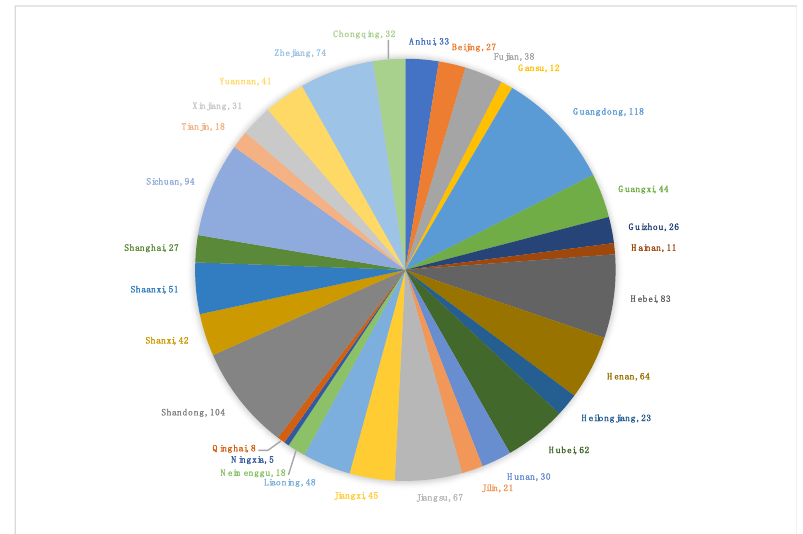
Figure 1. The composition of enrolled hospitals from 30 provinces in China.